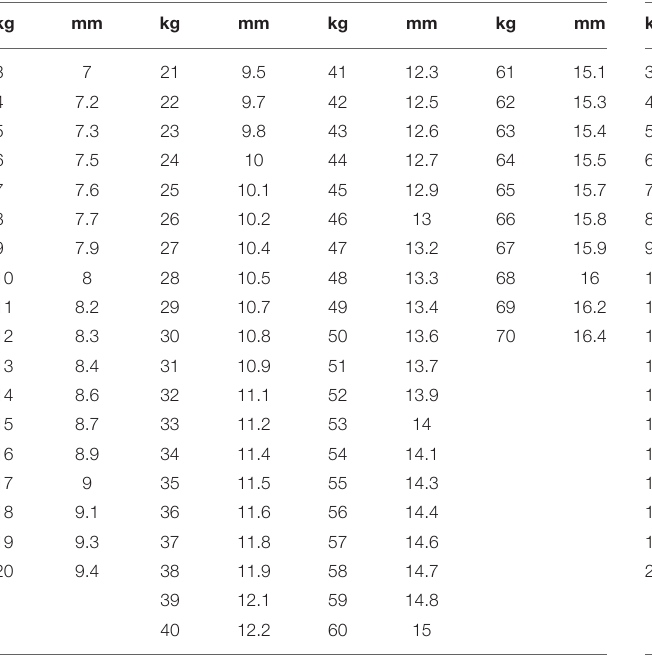
TABLE 1 | Mean diameter of the esophagus as calculated by regression line, upper measuring point.